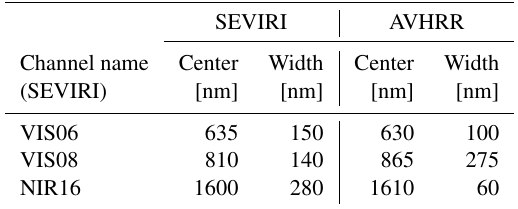
Table 1. Spectral characteristics of SEVIRI and AVHRR